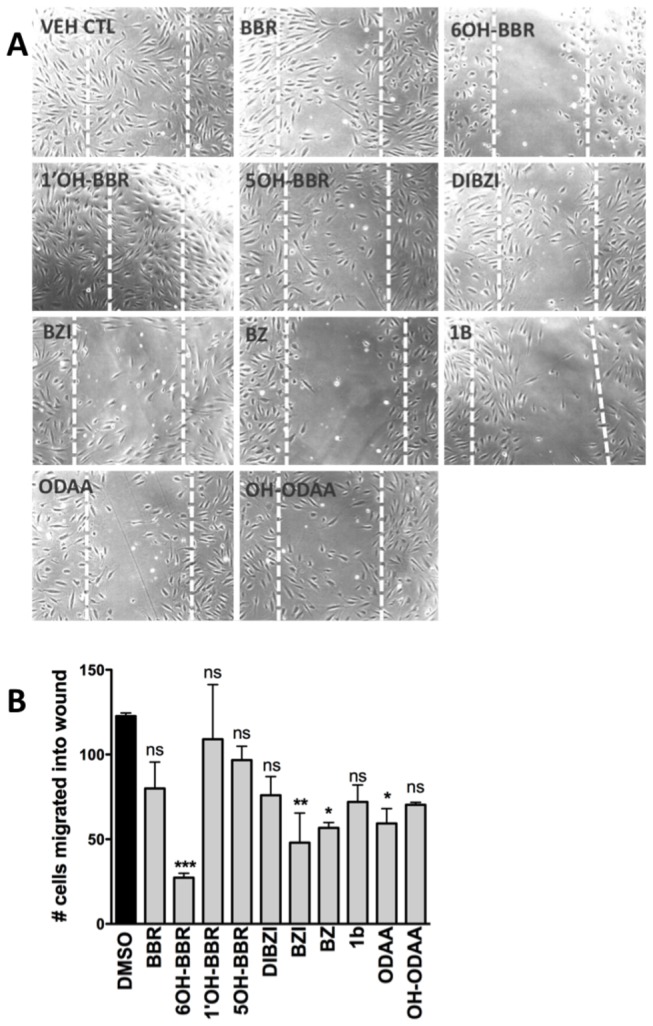
Lateral migration of HUVECs in the presence of test compounds.(A) HUVECs were scratch wounded and then cultured in the presence of either vehicle or 7.5 μM test compound. Representative phase-contrast photographs were taken 22 hours after wounding. White dotted lines indicate location of edges of the original wound. (B) Number of cells that migrate into the wounded area was counted using the Cell Counter functionality of ImageJ. Data represent three independent experiments and asterisk represent significant differences between groups (*** P<0.001, ** P<0.01, * P<0.05, ns not significant).